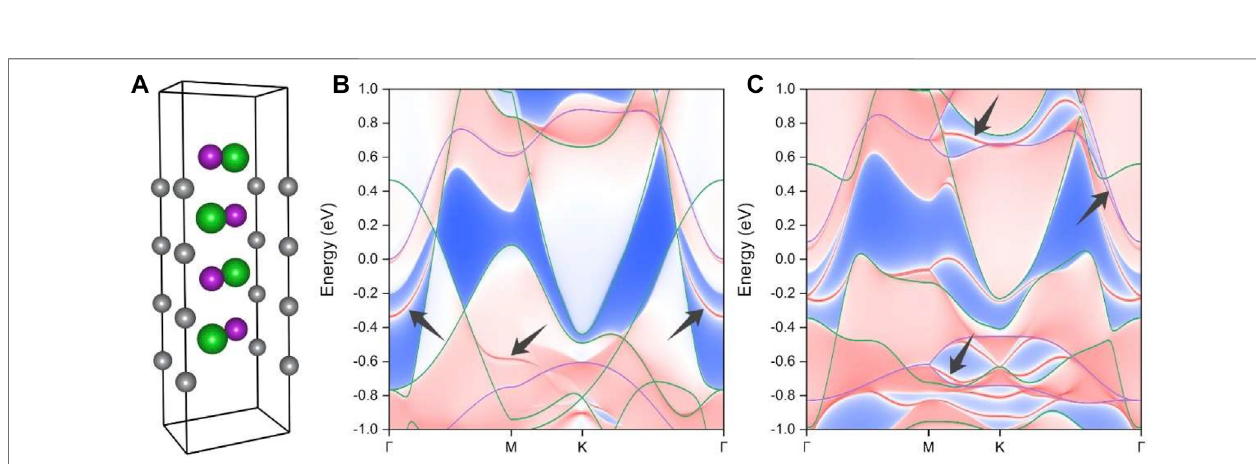
FIGURE 6 | (A) The slab model along the (001) surface with only a thickness of three unit cells for the surface state calculation. The calculated surface band projections (B) without and (C) with the SOC effect. The drumhead surface states that originated from the topological crossing points are indicated bythe black arrows.